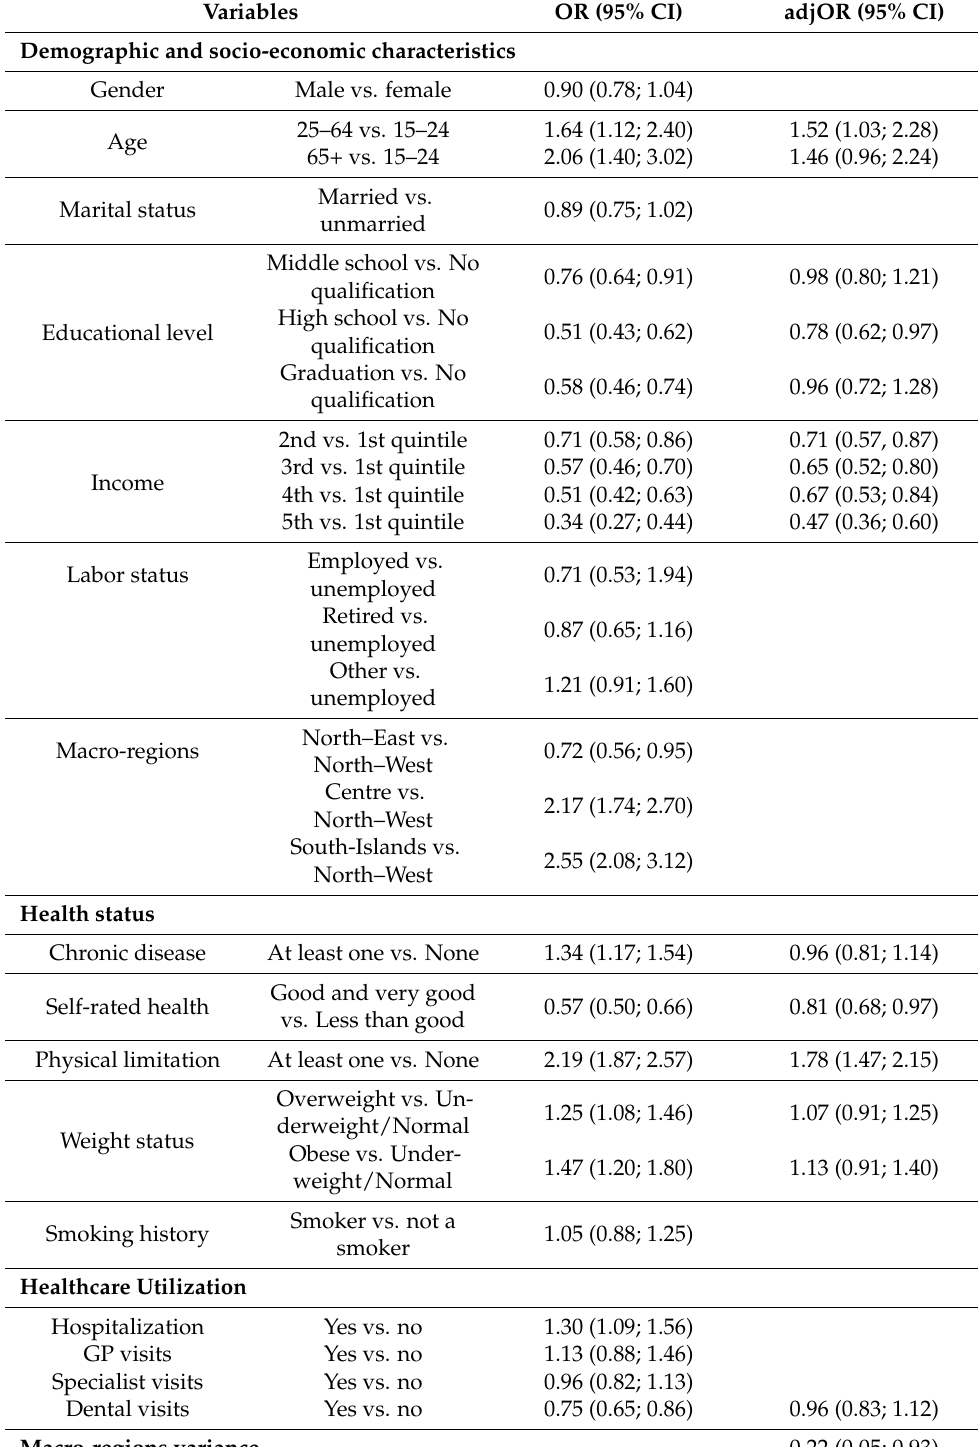
Table 3. Delayed utilization due to distance difficulties related to socio-economic and health charac- teristics of respondents: Univariable and multivariable analyses. Variables Demographic and socio-economic